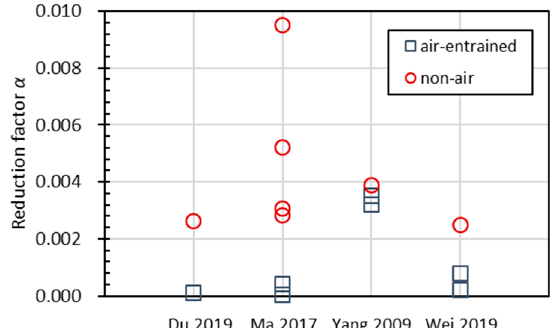
Figure 21. The reduction speed α for air-entrained and non-air-entrained concrete.